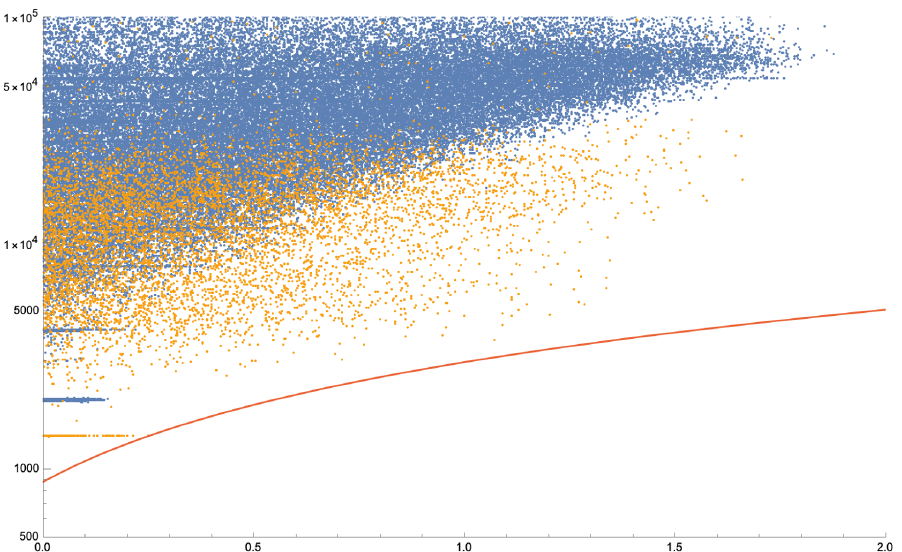
Figure 2 . Dependence of N flux on the Kähler-cone parameter c . Note that N flux is shown on a logarithmic scale. The blue data points are solutions with f 0 6 = 0 or h 0 6 = 0 , the orange data points are solutions with f 0 = h 0 = 0 , and the red curve is the lower bound on N equation